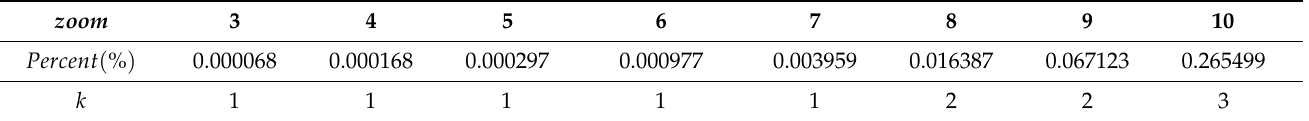
Table 1. The area ratio of Region A to the visible region.